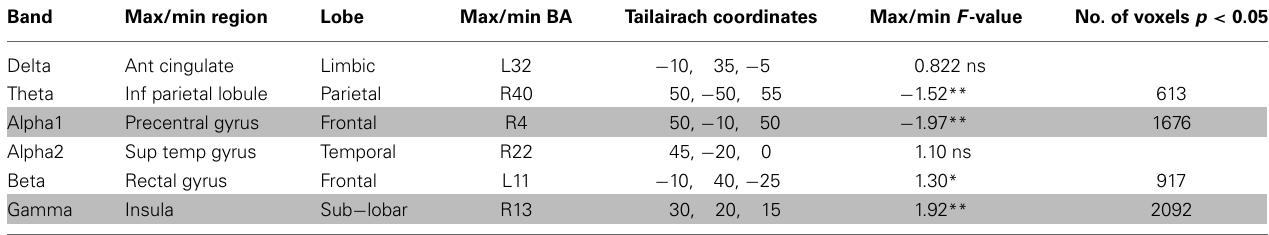
Table 2 | SYT > SYS comparison for Meditation 2—(Mantra).